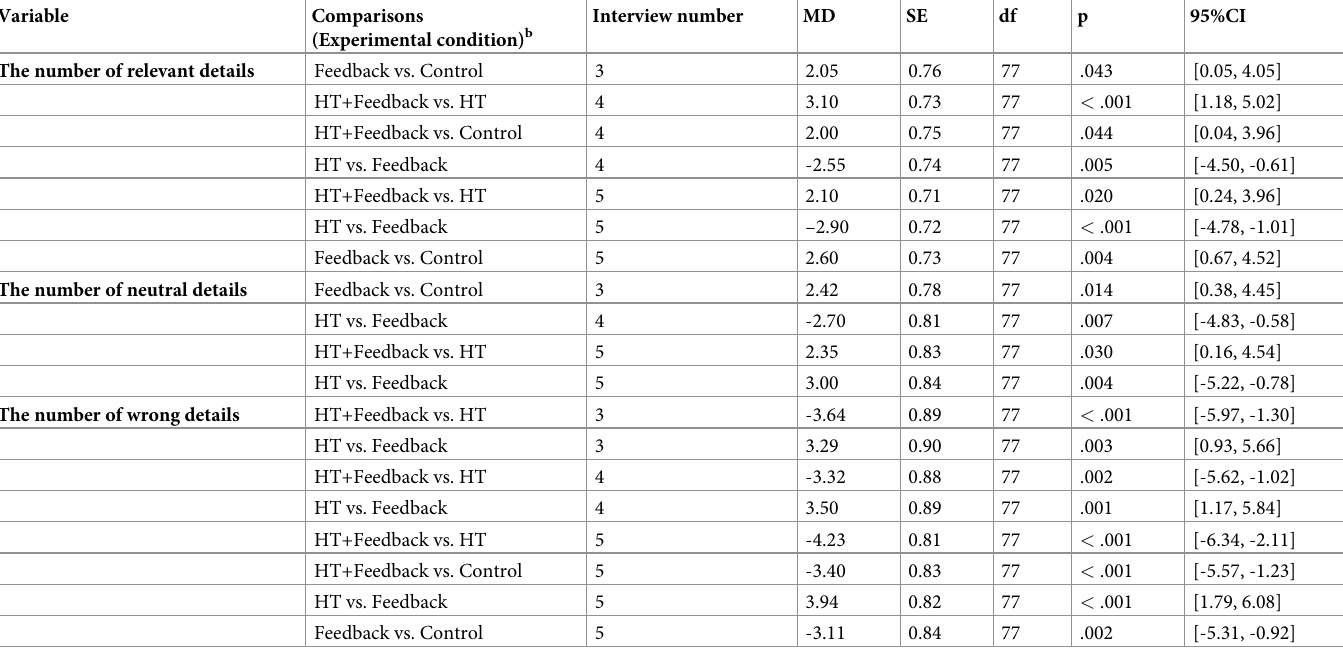
Table 6. a Planned comparisons on the types of details between experimental conditions over